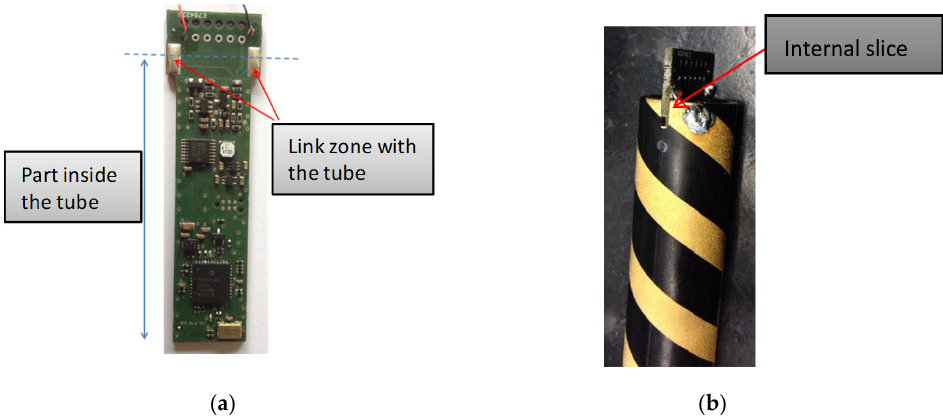
Figure 28. ( a ) PCBA embedded electronic measurement; ( b ) Interconnection between PCBA and the sensor tube.